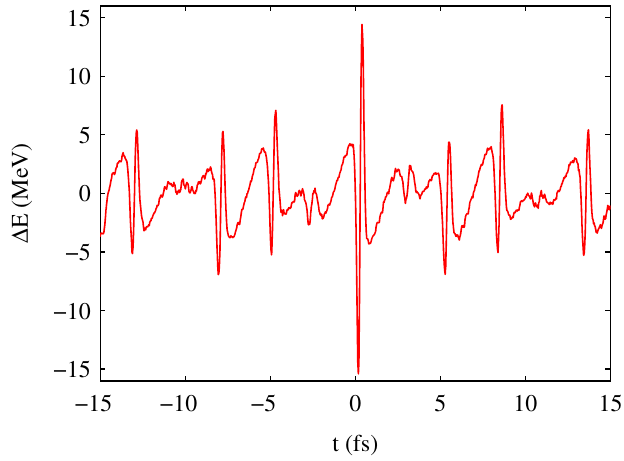
FIG. 4. (Color) Electron bunch energy modulation from the LSC field after a distance of 50 m in the LCLS undulator. The bunch head is to the right, as in the following figures.